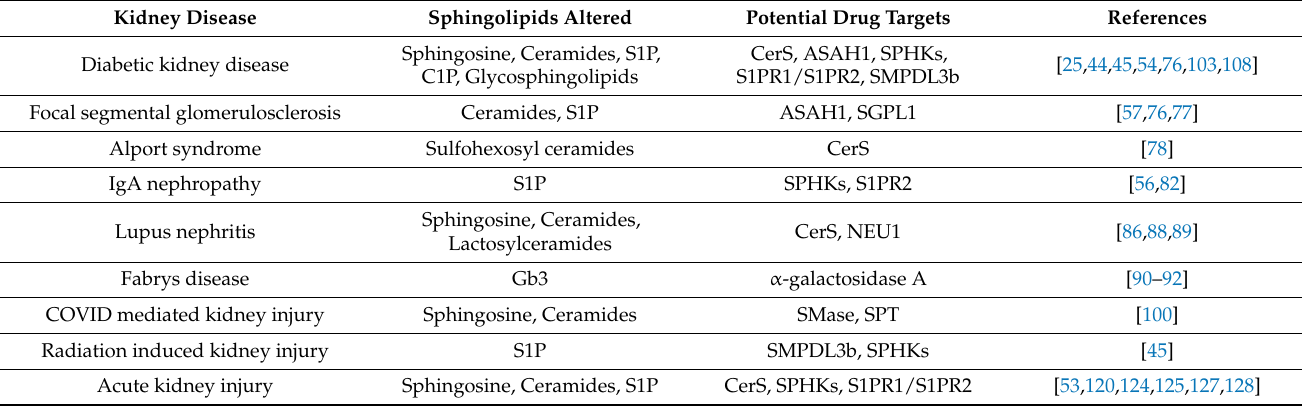
Table 1. Summary of sphingolipid species altered in different types of kidney diseases and the potential drug targets for the treatment of the different kidney